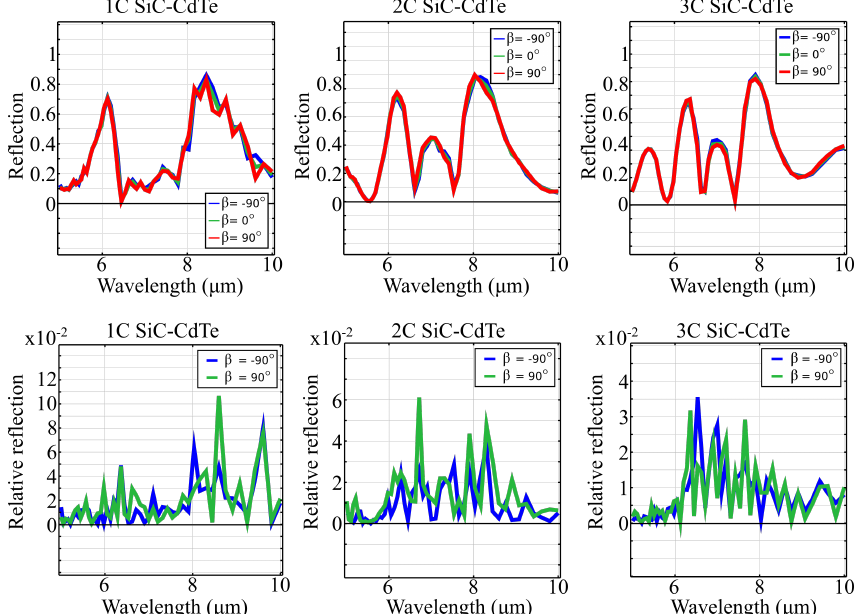
Figure 4. Absolute reflection (top line) and relative reflection (bottom line) spectra of structures 1C, 2C and 3C, under circularly-polarized electric field, at different values of the polarization angle β . The metasurface architecture is non-chiral, with relative reflection values below 10% across the spectral window.